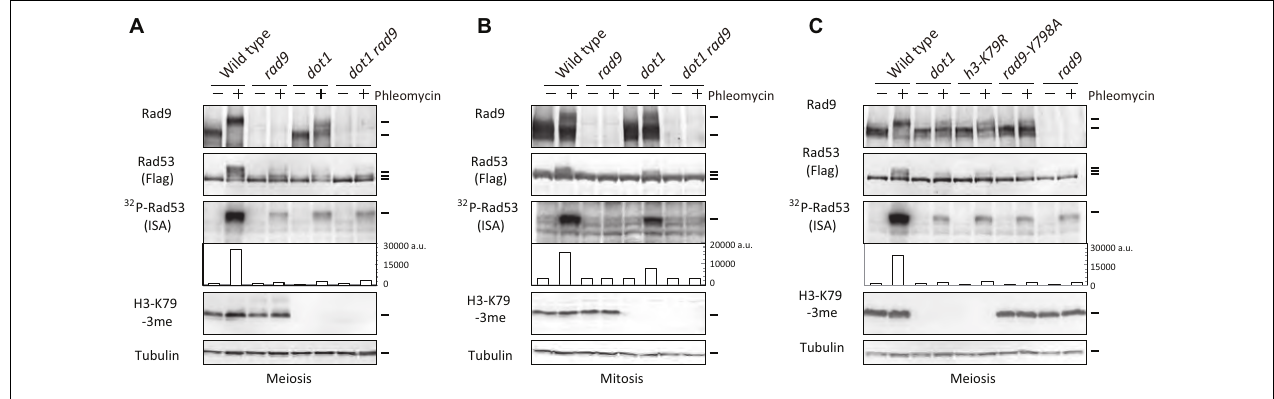
FIGURE 1 | H3K79me is required for Rad9-dependent Rad53 activation in meiosis after phleomycin treatment. (A) TCA-precipitated cell extracts were prepared from wild-type (USY543/544), rad9 (USY524/525), dot1 (USY526/527), and dot1 rad9 (USY522/523) diploid strains, and were analyzed by western blotting using anti-Rad9, anti-Flag (for Rad53), anti-H3K79-3me, and anti-tubulin antibodies. “ 32 P-Rad53” represented 32 P-incorporation to Rad53 in the ISA assay. Band intensities were quantified and are shown as arbitrary units without normalization (fourth panels). Cell extracts derived from 4 × 10 6 cells were loaded for the ISA assay. (A,C) Cell extracts were prepared from 3.5-h meiotic cells before (labeled as “–”) and after 30-min treatment with 5 µ g/mL of phleomycin (labeled as “+”). (B) Diploid cells of the indicated strains were arrested at G2/M by nocodazole and treated with 5 µ g/mL of phleomycin for 30 min, followed by TCA precipitation. Wild-type (USY543/544), rad9 (USY524/525), dot1 (USY526/527), and dot1 rad9 (USY522/523) were used in the experiment. Results of an independent experiment are shown in Supplementary Figure 1A . (C) Rad53 activation was examined in various strains in meiosis as shown in (A) . Wild-type (USY543/544), rad9 (USY524/525), dot1 (USY526/527), h3-K79R (USY693/677), and rad9-Y798A (USY758/759) diploid strains were used. Results of an independent experiment are shown in Supplementary Figure 1B